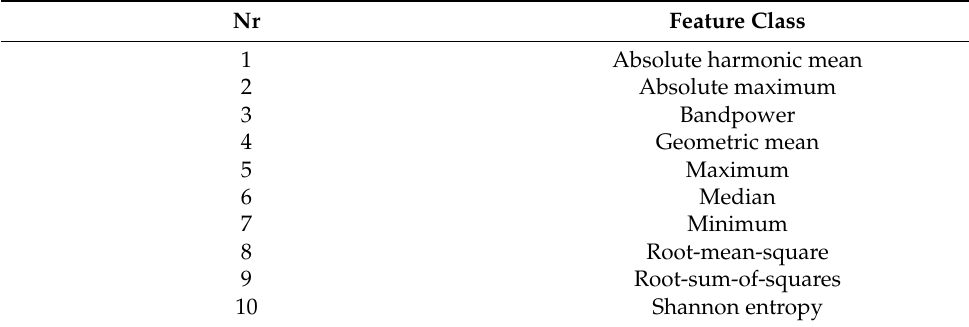
Table 2. Overview of the 10 feature classes passed the feature selection round.